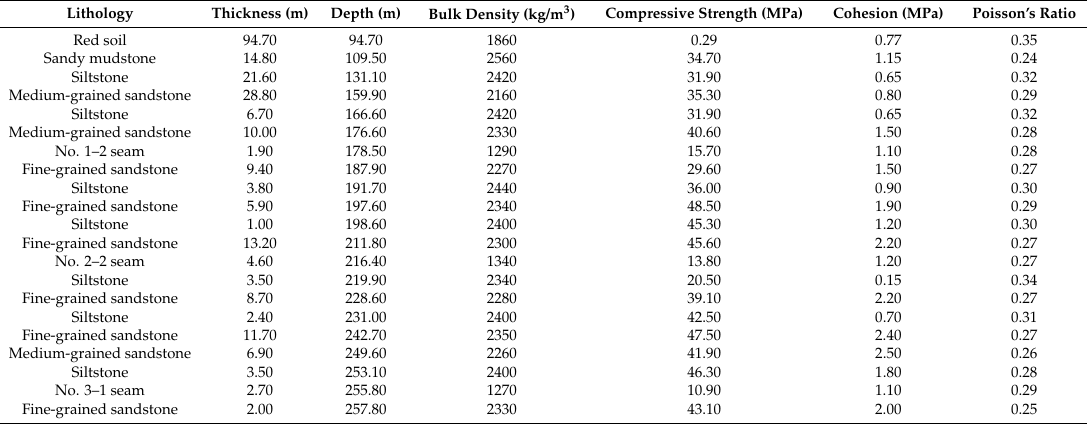
Table 1. The parameters of coal and its roof and